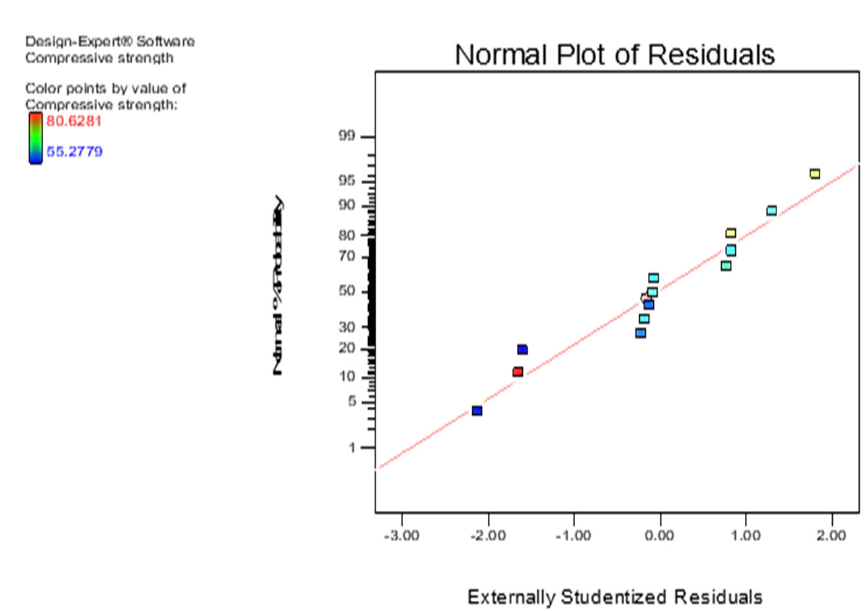
Figure 11. Normal plot of residuals of compressive strength.